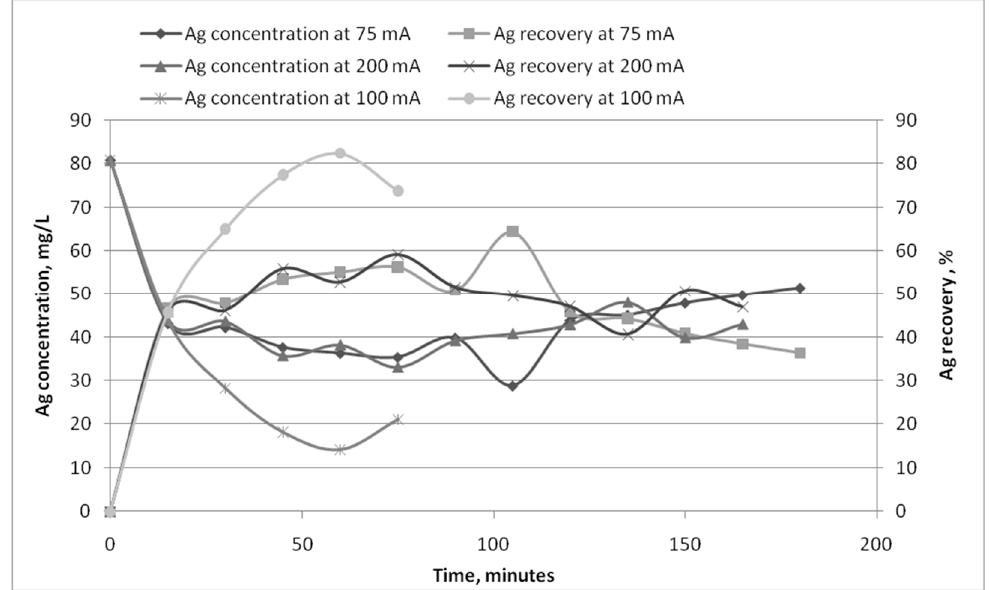
Figure 6. Evolution of Ag concentration and recovery from solution at various current intensities vs. process time.